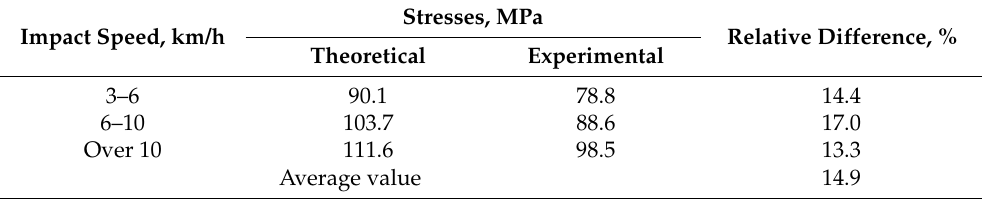
Table 2. The analysis of theoretical and experimental stresses in the flatcar frame (strain gauge 5). Impact Speed, km/h